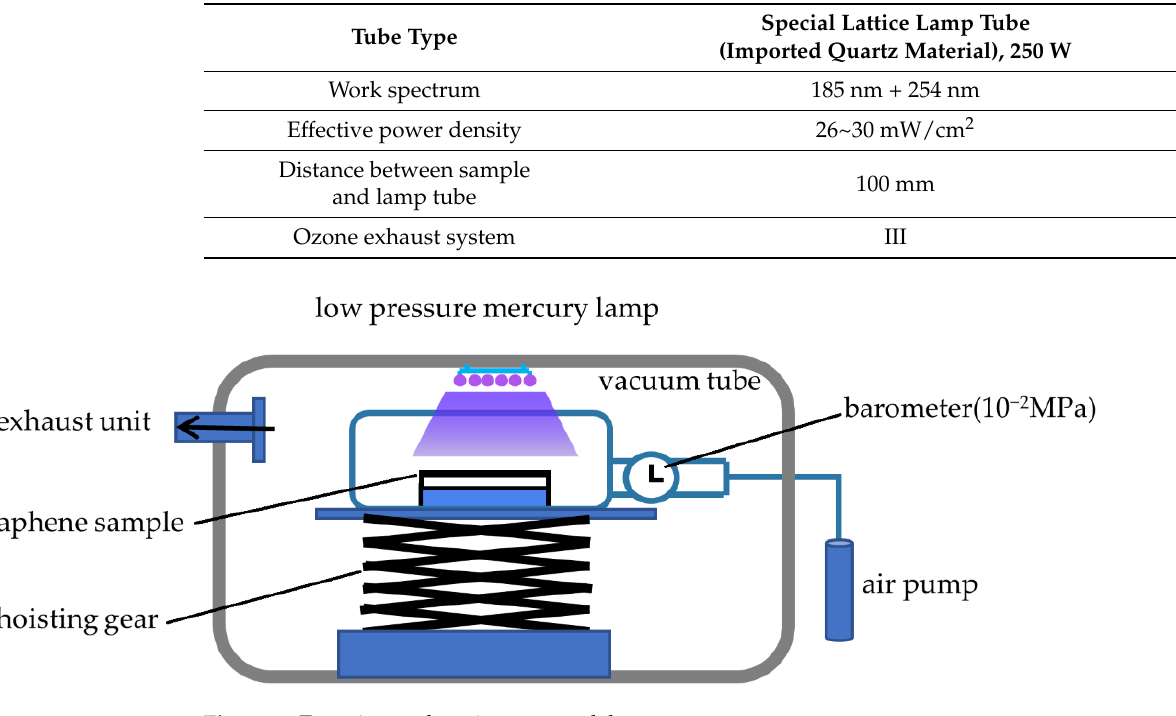
Figure 2. Experimental equipment model. Table 1. Experimental parameters of BZS250GF-TS UV